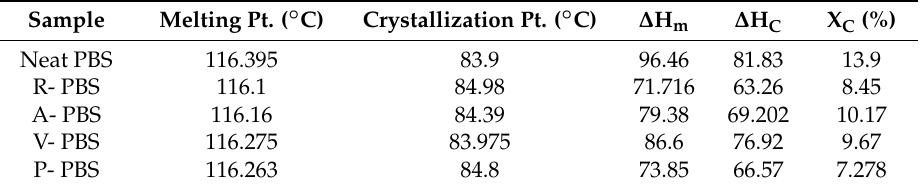
Table 1. Crystallization and melting behavior of neat PBS and its composites.